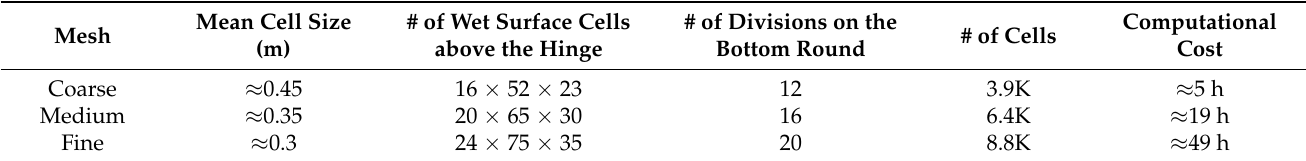
Figure 6. The selected mesh model (medium size) of mean wet surface input into NEMOH for computation of hydrodynamic coefficients. Table 2. The mesh statistics and computational cost (on 1 processor) for three configurations of grids in